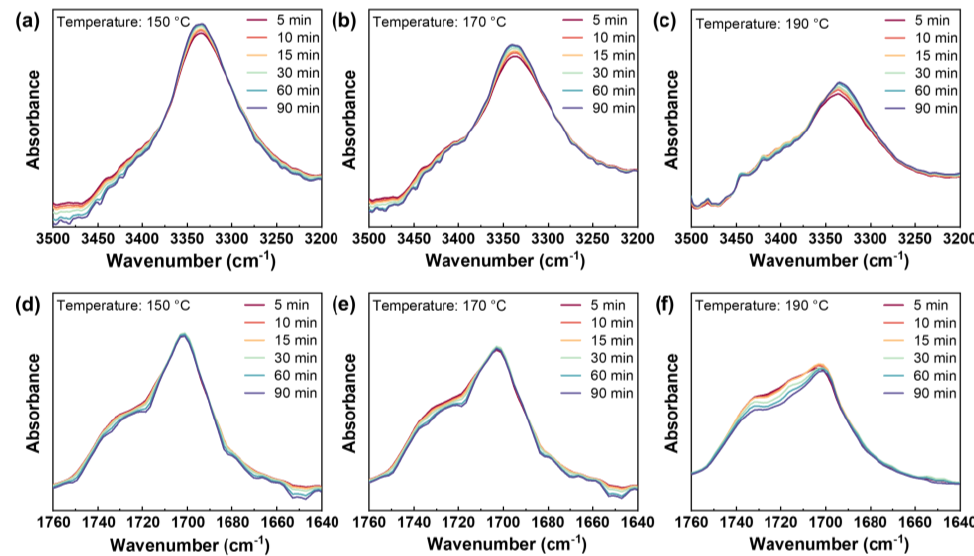
Figure 2. N-H peak spectra over time during annealing at ( a ) 150 °C, ( b ) 170 °C, and ( c ) 190 °C. C=O peak spectra over time during annealing at ( d ) 150 °C, ( e ) 170 °C, and ( f ) 190